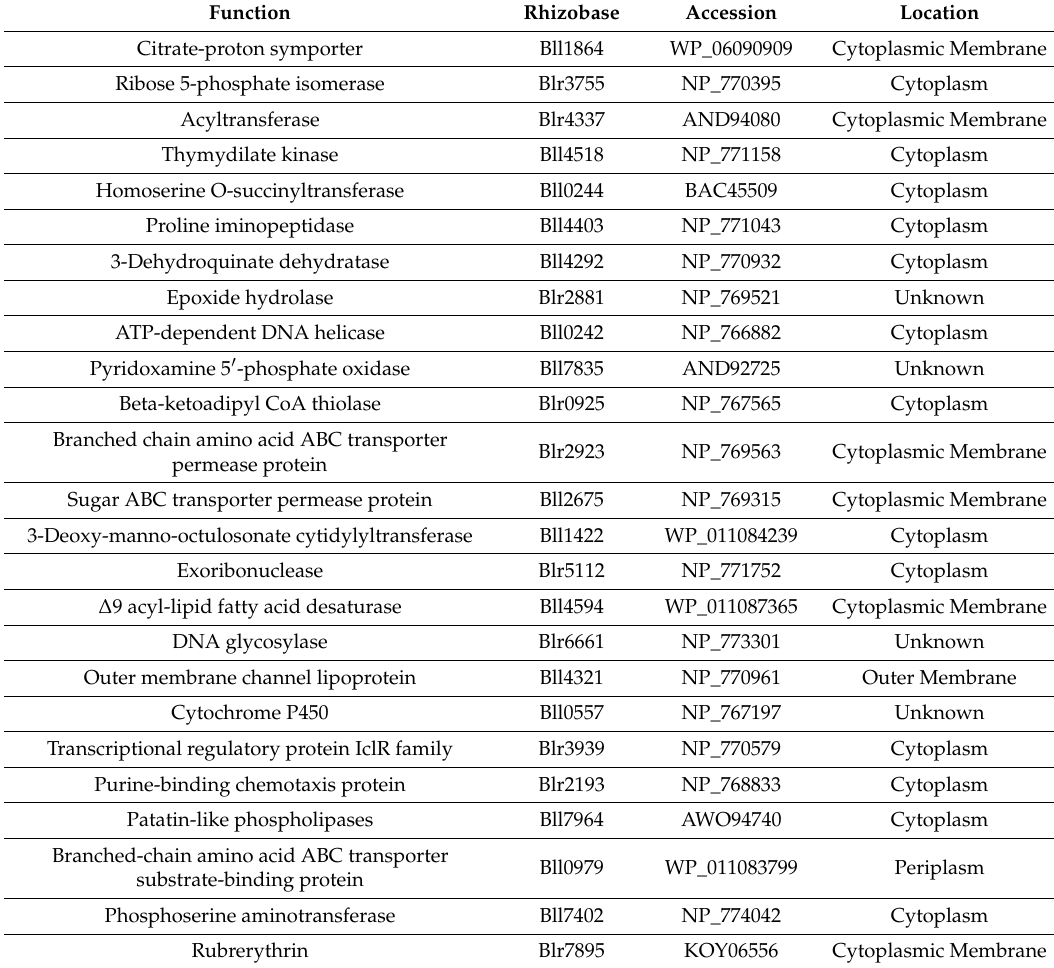
Table 4. Examples of B. diazoefficiens genes expressed during the senescence of soybean root nodules following the pattern displayed in Figure